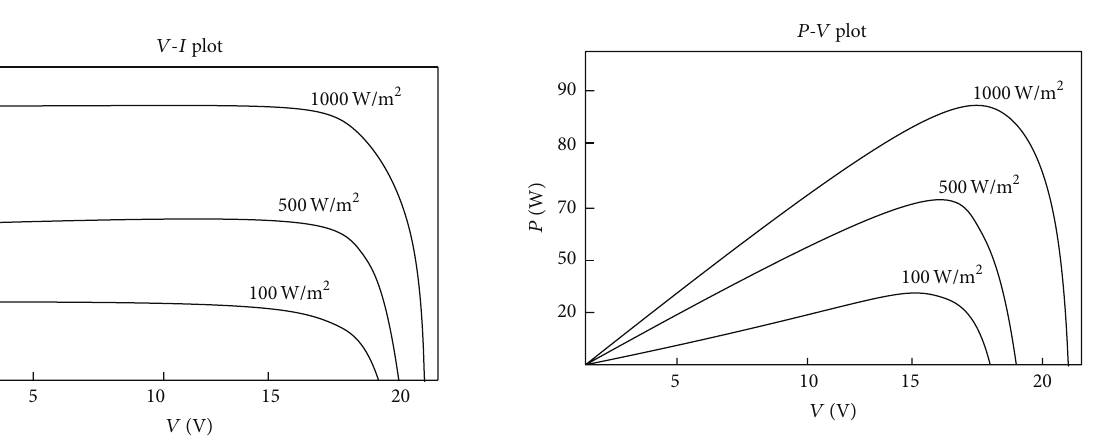
Figure 9: Characteristics curve for Kyocera KC85T 87 W module . 𝑃 - 𝑉 curves of KC85T 87 W at different